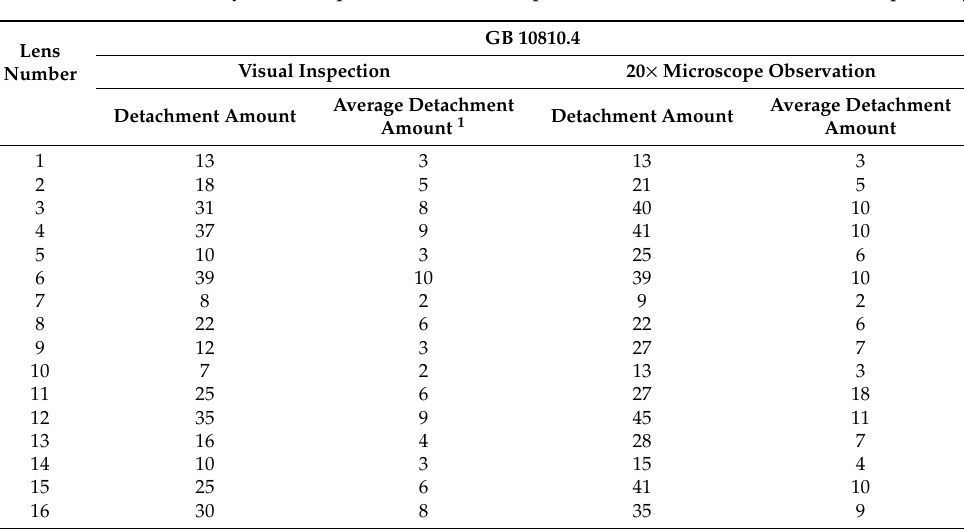
Table 4. Results obtained by visual inspection and microscope observation based on GB10810.4